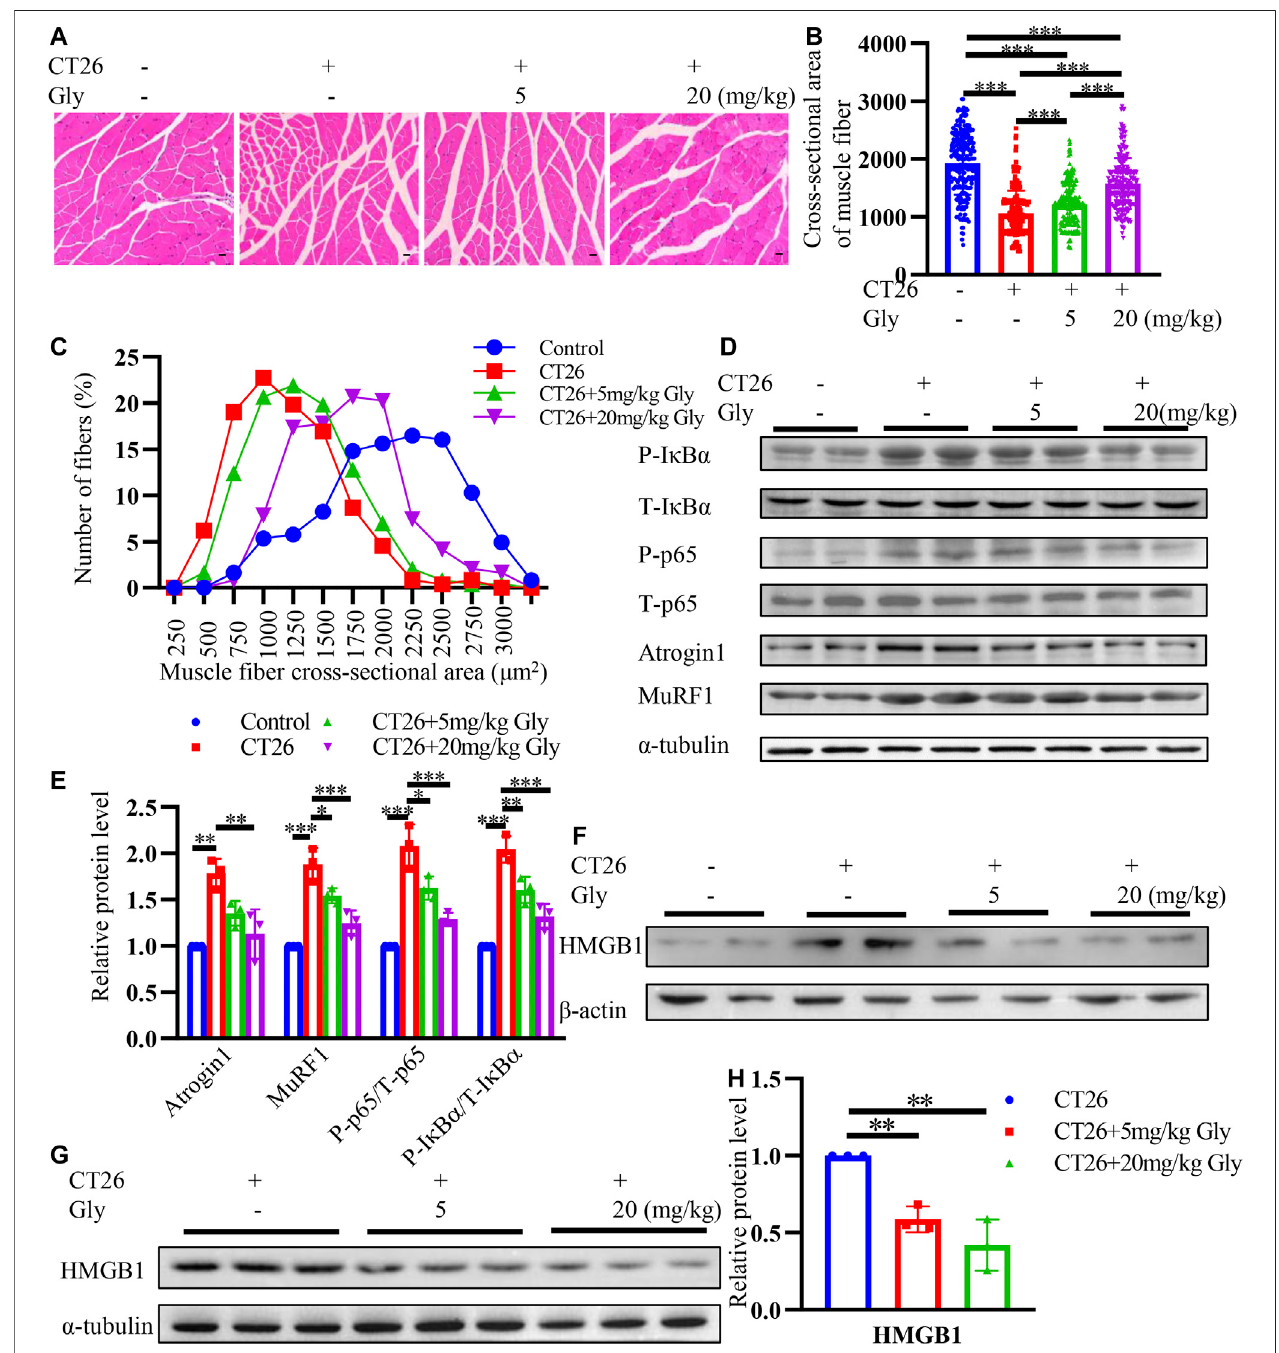
FIGURE8| HMGB1inhibitorglycyrrhizin alleviates musclewastingthrough NF- κ Bsignaling pathway in CT26 tumor-bearingmice. (A) Hematoxylin and eosin(HE) staining of gastrocnemius muscle. Scale bar (cid:2) 100 μ m (B) Cross-sectional area analysis of gastrocnemius muscle. (C) Distribution of gastrocnemius cross-sectional area. (D) Total extracts of gastrocnemius muscle were used for western blotting analysis with antibodies against with P-p65, P65, P-I κ B, I κ B, Atrogin1, MuRF1 and α -tubulin. (E) Densitometric quanti fi cation of the P-P65 signal relative to total P65 signal, P-I κ B signal relative to total I κ B signal, the Atrogin1 and MuRF1 signal relative to the α -tubulin signal. (F) HMGB1 levels in mice serum exosomes. (G) Total extracts of tumor tissues were used for western blotting analysis with antibodies against with HMGB1. (H) Densitometric quanti fi cation of the HMGB1 signal relative to the α -tubulin signal.